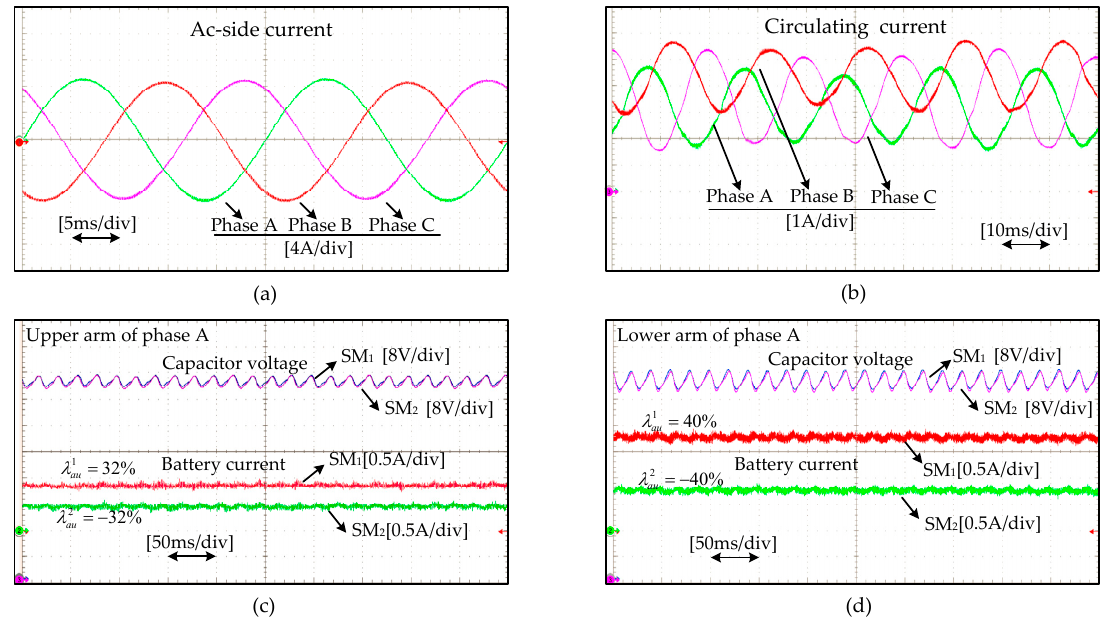
Figure 11. Steady ‐ state waveforms of MMC ‐ BESS with optimized SOC balancing control method: ( a ) AC ‐ side current; ( b ) circulating current; ( c ) capacitor voltage and battery current of upper arm in phase A; ( d ) capacitor voltage and battery current of lower arm in phase A.